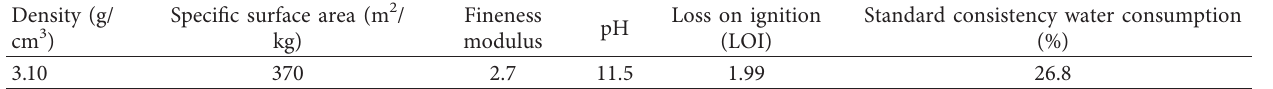
Table 1: The performance parameters of cement used in this experiment.